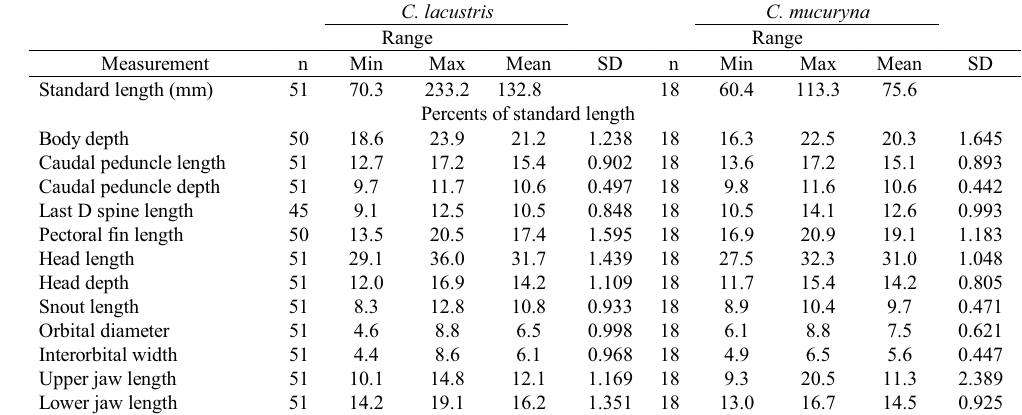
Table 1. Morphometry of Crenicichla lacustris and C. mucuryna . n= number of specimens; SD= Standard